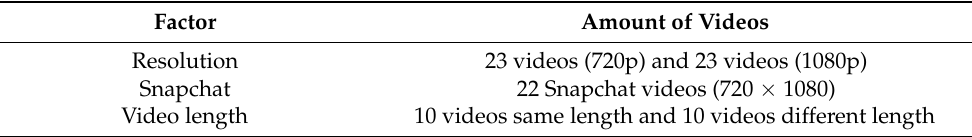
Table 1. Overview of the amount of videos per factor